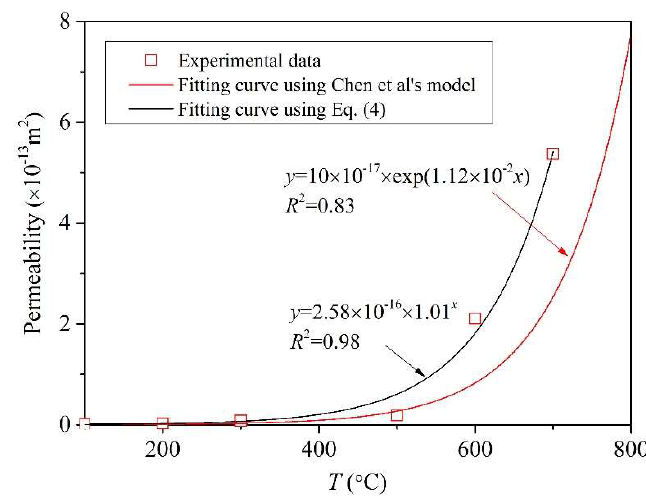
Figure 8. Evolution of permeability versus heat treatment temperature.